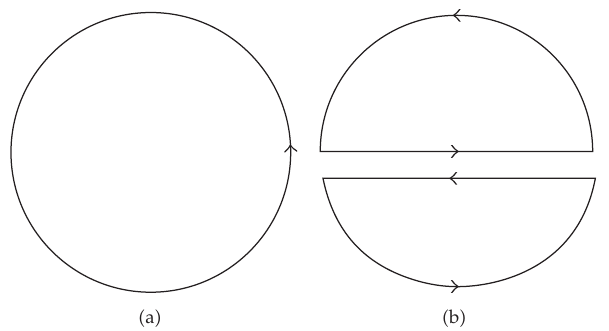
Figure 11: A quark vacuum bubble and a quark vacuum bubble with “gluon” exchange. Created by Brian